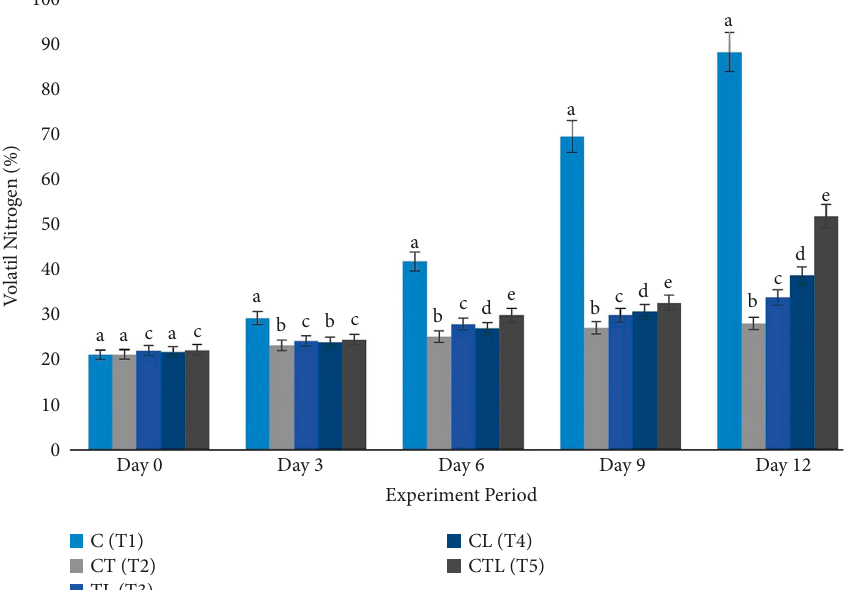
Figure 8: Percentage of volatile nitrogen content in the carp fillet immersed in mixed different extracts of turmeric, cinnamon, and lemon at 4 °